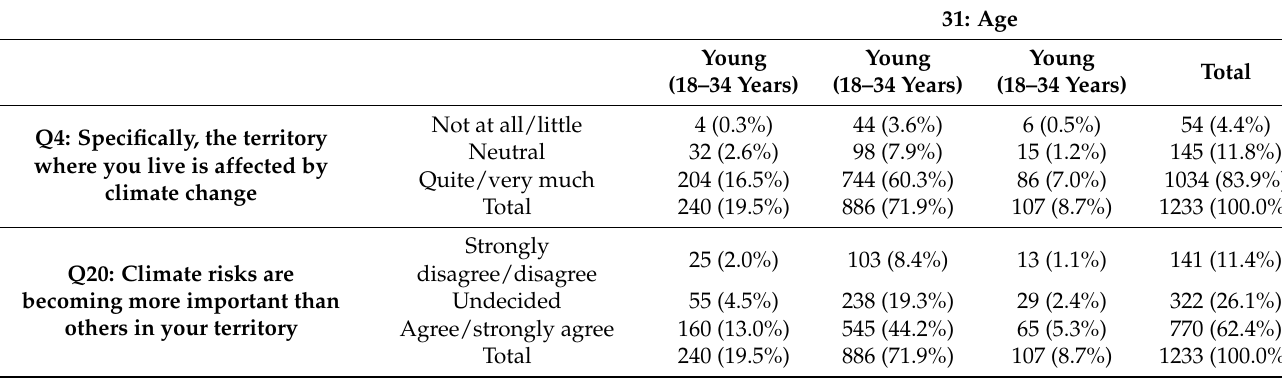
Table A5. Cross table of Q1 and Q33, Q4 and Q33, and Q20 and Q33, with frequencies (percentages) of the answers.